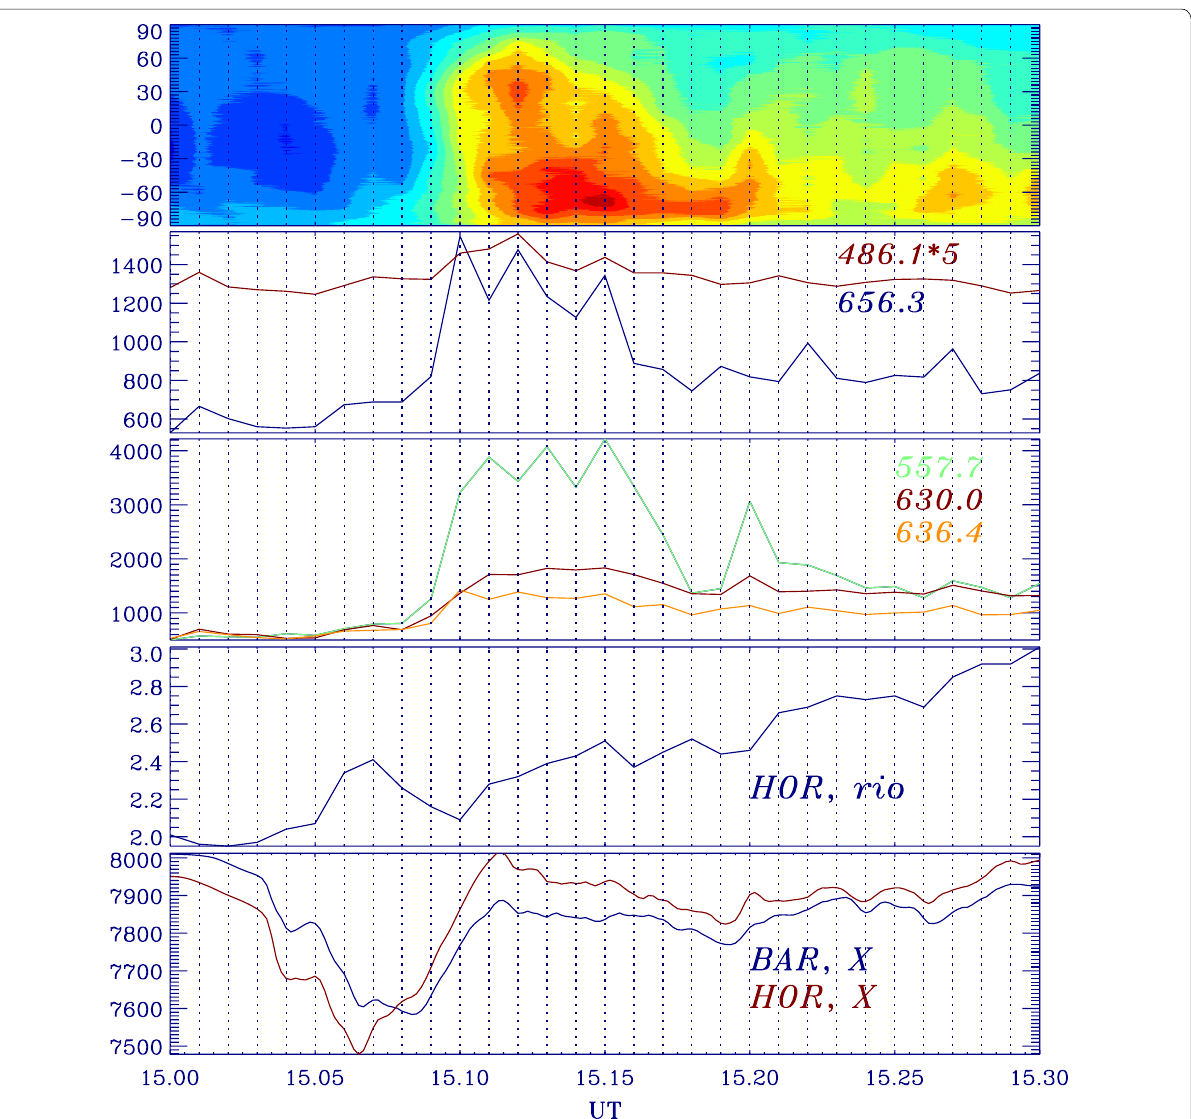
Fig. 9 Keogram of 630.0 nm emission intensity (scan angle—UT) produced from the digital image of the NORUSCA hyperspectral all-sky imager (Barentsburg); intensity variations (in Rayleigh) of emissions produced by proton precipitation 486.1 nm (multiplied by 5) and 656.3 nm, and by elec- tron precipitation 557.7, 630.0, and 636.4 nm, riometer (in dB), and geomagnetic (X-component) (in nT) variations at stations HOR and BAR